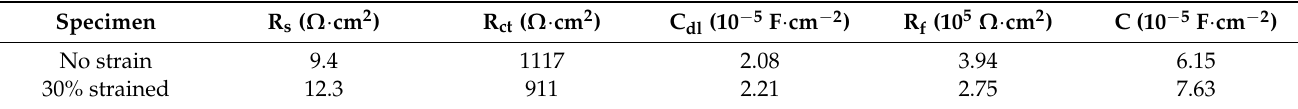
Figure 9. Electrical equivalent circuit used for the EIS data analysis of the oxide films grown on Alloy 600 specimens in simulated PWR secondary water at 340 ◦ C. Table 2. Electrochemical impedance parameters for the oxide films grown on Alloy 600 specimens in simulated PWR secondary water at 340 ◦